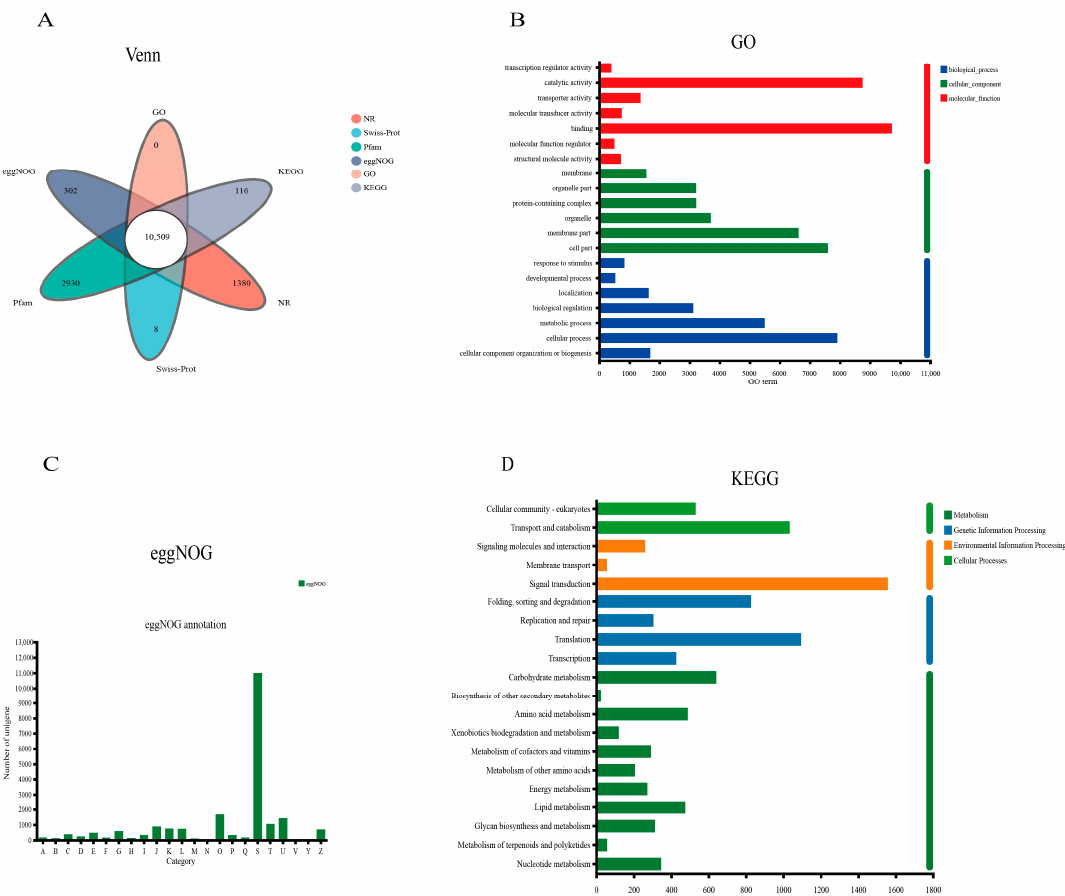
Figure 2. Annotation of the unigenes obtained from the transcriptome assembly of S. paramamosain . ( A ) Venn diagram of the total unigenes annotated into the six databases (NR, Siwss-Prot, Pfam, eggNOG, GO, and KEGG), the central white part is the number of common genes. ( B ) GO annotation results are summarized into three main categories (biological process, cellular component, and molecular function). ( C ) eggNOG annotation of the total unigenes; the results are classified into 23 categories. ( D ) KEGG annotation of the total unigenes are assigned into four main categories (metabolism, genetic information processing, environmental information processing, and cellular